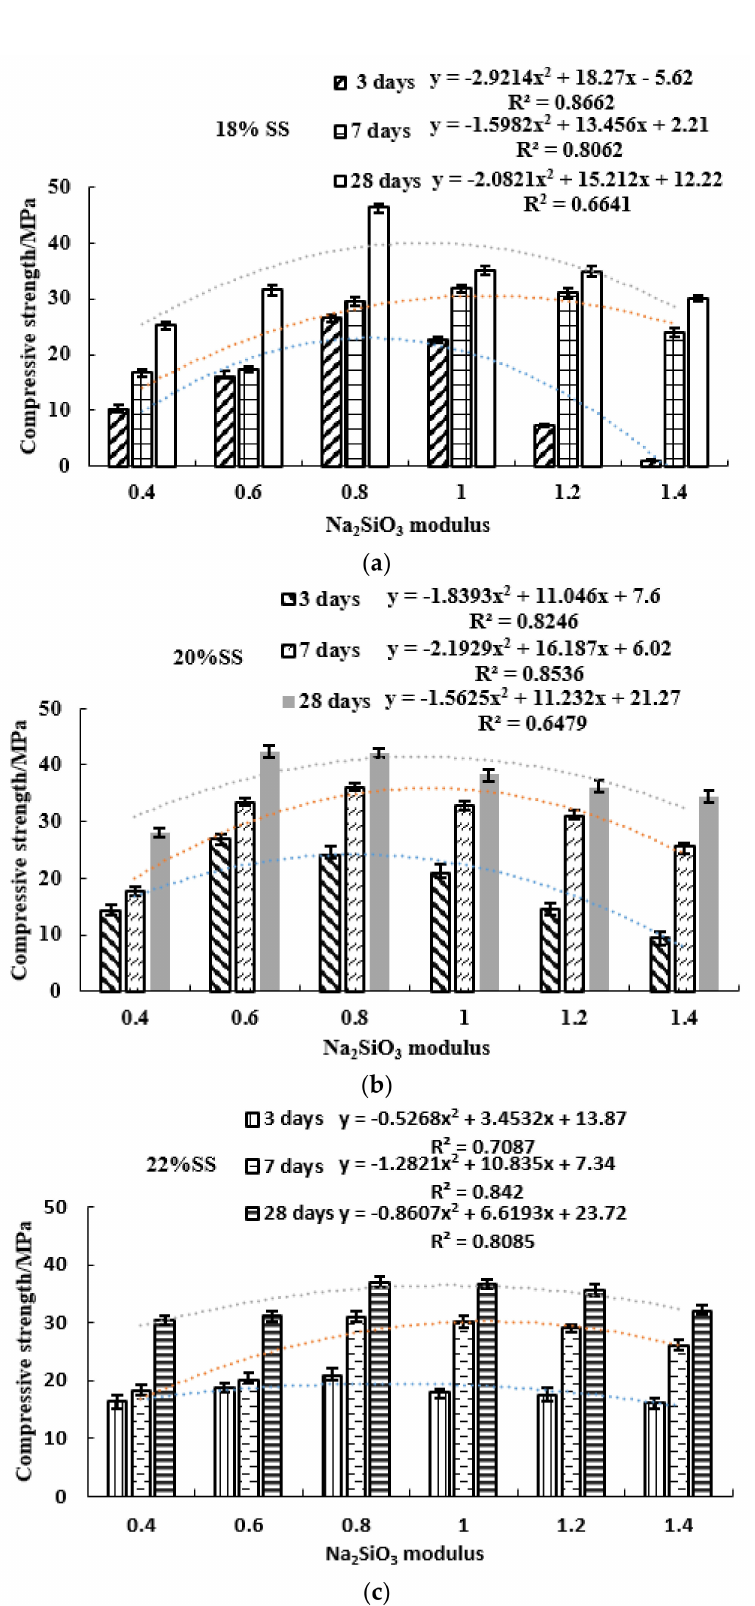
Figure 8. Compressive strength of different modulus geopolymers at 3, 7, 28 days. ( a ) 18% SS ( b ) 20% SS ( c ) 22%